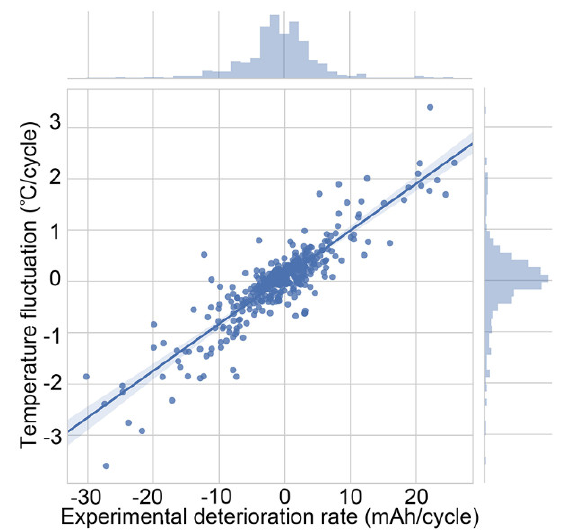
Figure 11. Correlation analysis between the deterioration rate and the temperature fluctuation.